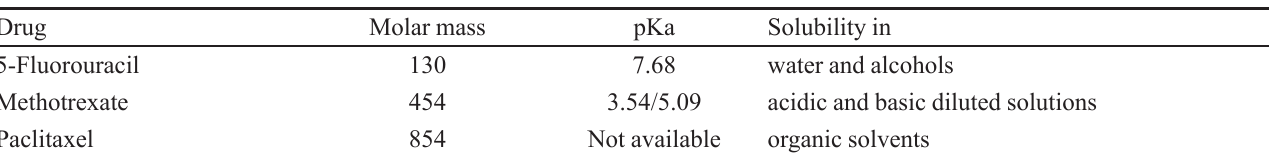
TABLE I - Molar mass, pKa and solubility of three antineoplastic drugs frequently used in clinical practice (Reynolds, 1996; O’Neil, 2006; Scifinder, 2006)